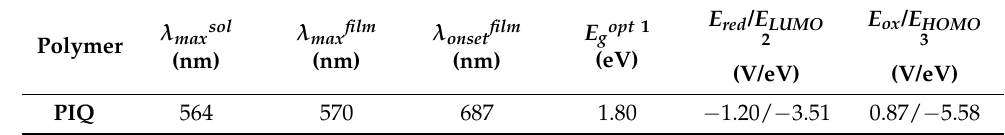
Table 1. The optical and electrochemical properties of PIQ .